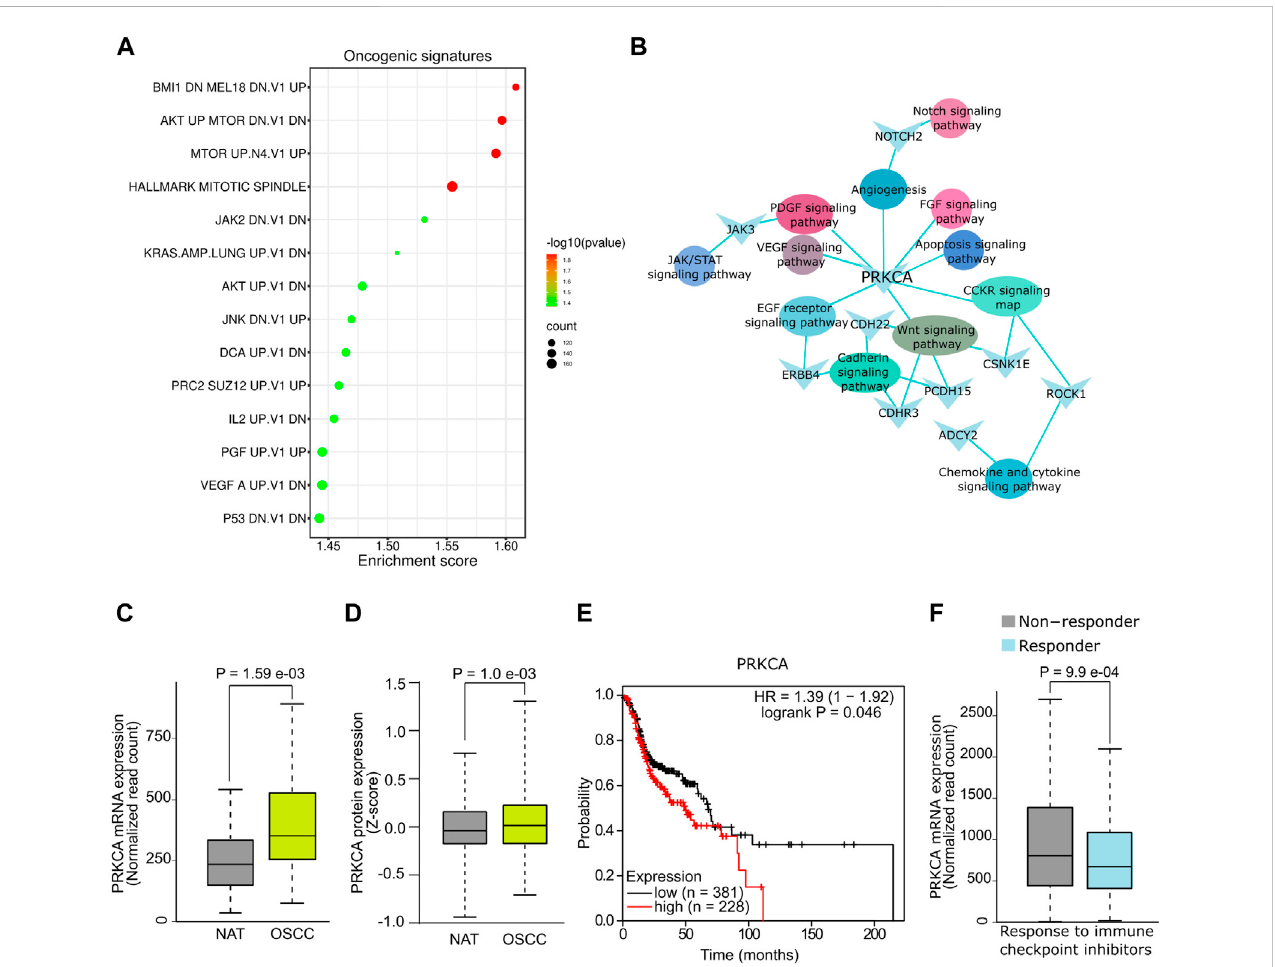
FIGURE 2 Functional analysis of salivary mRNAs. (A) GSEA showing association of DE mRNAs with oncogenic gene sets. (B) Functional networks showing DE hub mRNAs associated with multiple cancer pathways. DE of PRKCA at mRNA (C) and protein (D) levels inOSCC. (E) Survivalplot showing reduced overallsurvival with high PRKCA expression. (F) Response of OSCC patients with high PRKCA expression towards immune checkpoint